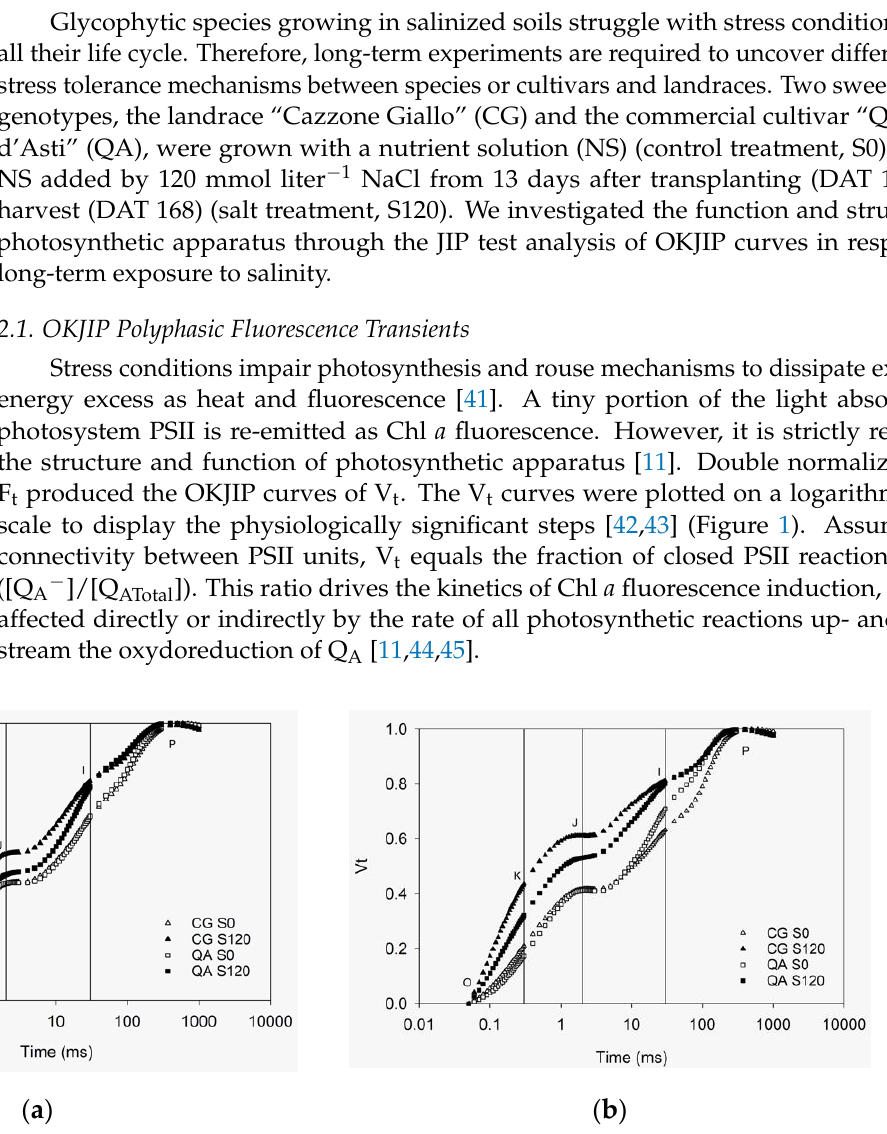
Figure 1. Polyphasic rise of relative variable fluorescence (V t ) upon illumination with saturating light of dark-adapted leaves of cultivar QA and landrace CG for treatments S0 and S120 measured on DAT 82 ( a ) and DAT167 ( b ). In each panel, the vertical lines intersect the K point at 300 µs (left line), the J point at 2 ms (middle line), and then I point at 30 ms (right line). Values are the means of 24 replicates.